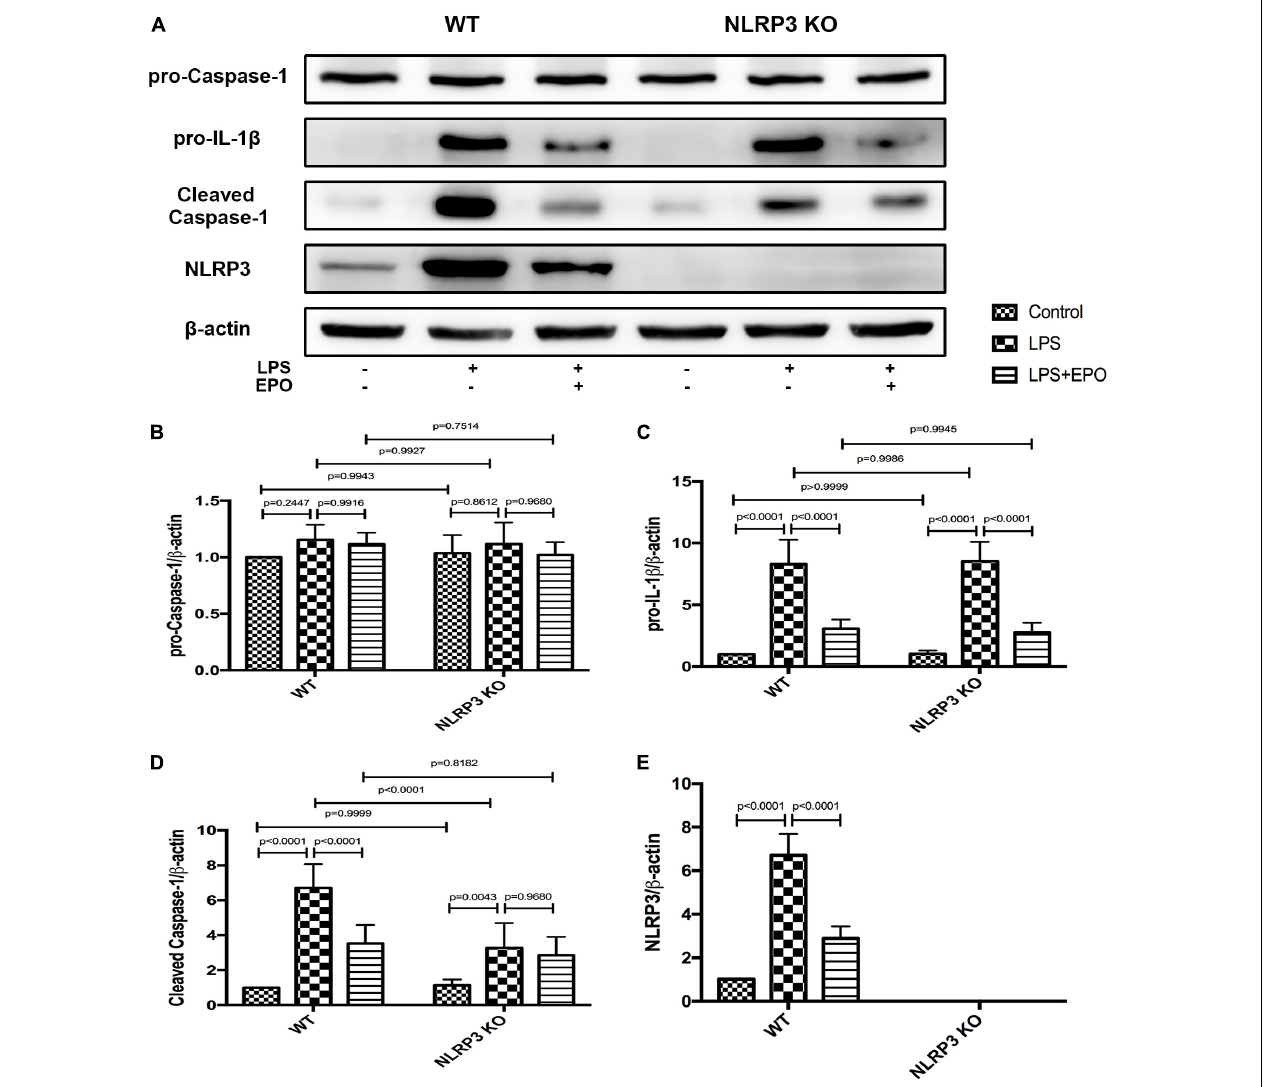
FIGURE 8 | The knockout of NLRP3 mimicked the effects of EPO on the NLRP3 inflammasome in ALI. EPO (5 U/g) was injected into the peritoneal cavity of mice after LPS (15 mg/kg) stimulation of NLRP3 knockout (KO) mice and wild-type (WT) mice, and the mice were sacrificed 8 h later. The lung tissues were harvested to measure the protein expression levels of pro-caspase-1, pro-IL-1 β , cleaved caspase-1, and NLRP3 (A–E) by Western blotting. The data are presented as the mean ± SD. The differences among groups were assessed by two-way ANOVA and the post hoc test (Turkey method) was applied to investigate the differences one by one. n = 7 per